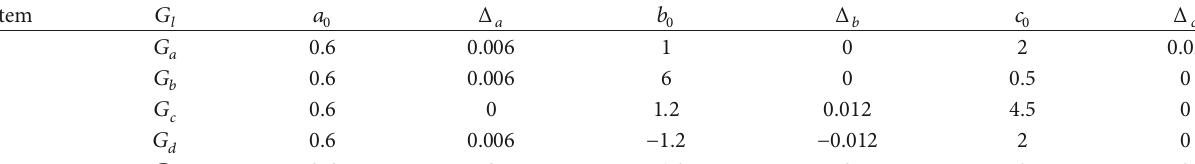
Table 1: Parameters of the nodes and the reference system.